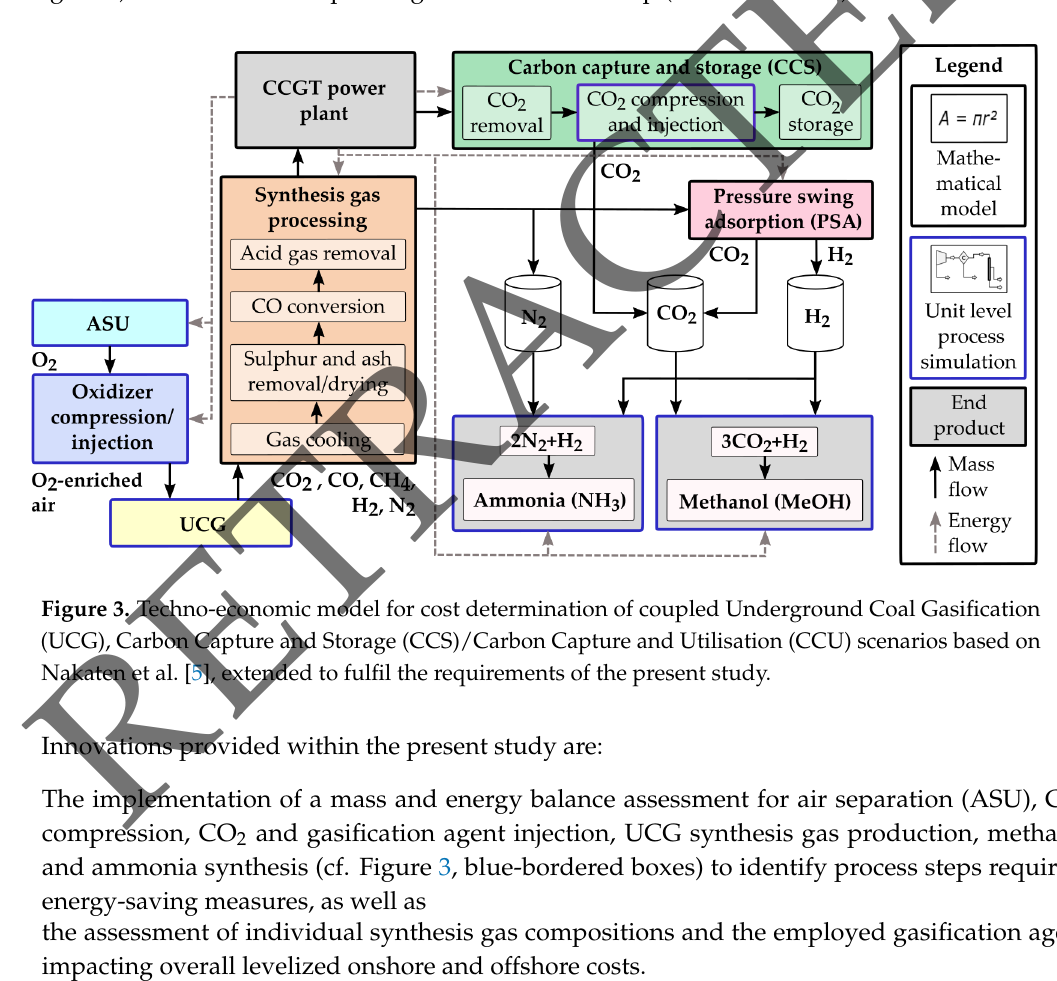
Figure 3. Techno-economic model for cost determination of coupled Underground Coal Gasification (UCG), Carbon Capture and Storage (CCS)/Carbon Capture and Utilisation (CCU) scenarios based on Nakaten et al. [5], extended to fulfil the requirements of the present